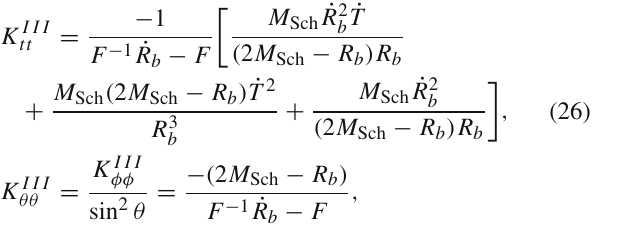
Fig. 2 Evolution of the effective density ρ (cid:5) concentrated on the boundary surface between region I and region III. The shell’s density increases in such a way that M (cid:5) + r 3 numerical parameters used in these plot are m I = 2, k I = 1 .